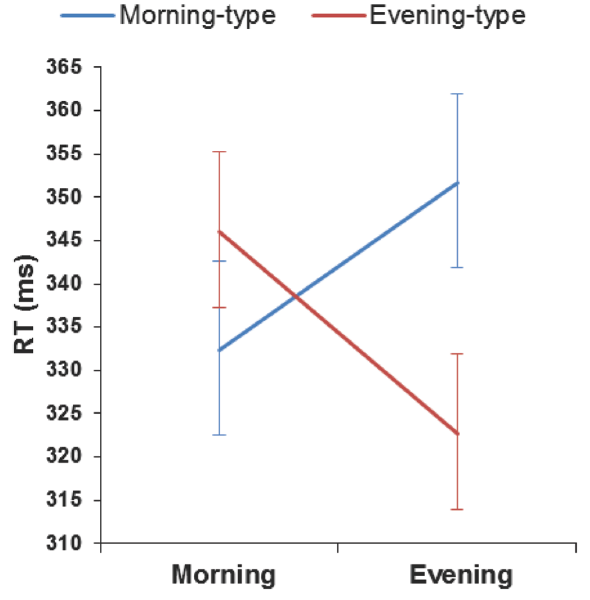
Figure 2. Mean reaction times on the PVT for both chronotypes depending on time of day. Each chronotype responded fastest at their optimal time of day and slowest at their non-optimal testing time. Vertical bars denote + / 2 standard error of the mean.